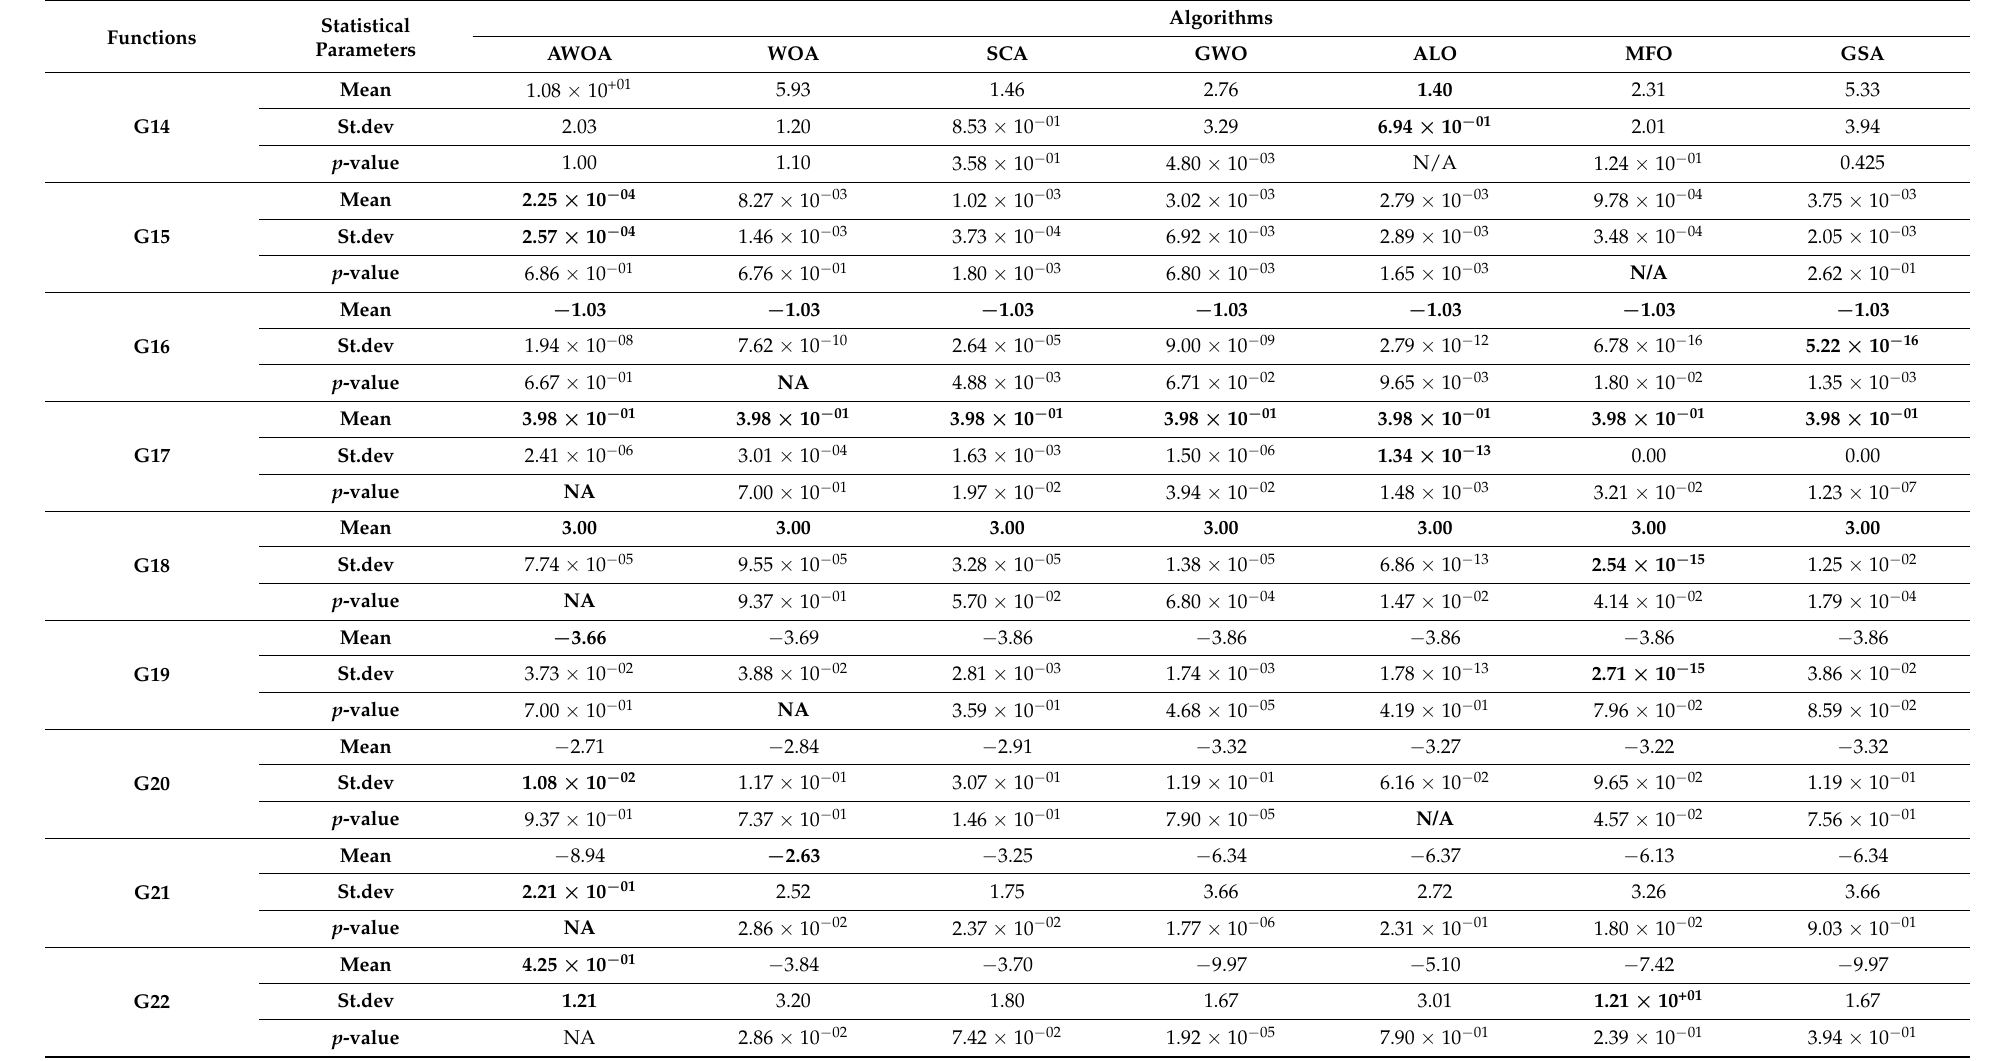
Table 7. Average, Standard Deviation, and p -Value of AWOA and other comparable algorithms for Multi-Modal Functions with Fixed Dimension.